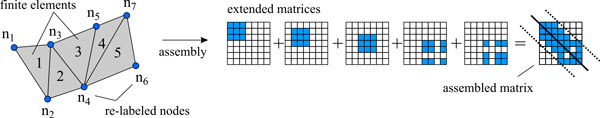
Assemblage of an FEM from elements. Elements are assembled by first re-labeling nodes, then extending the stiffness matrices accordingly (non-zero entries are indicated in blue) and then adding the matrices.